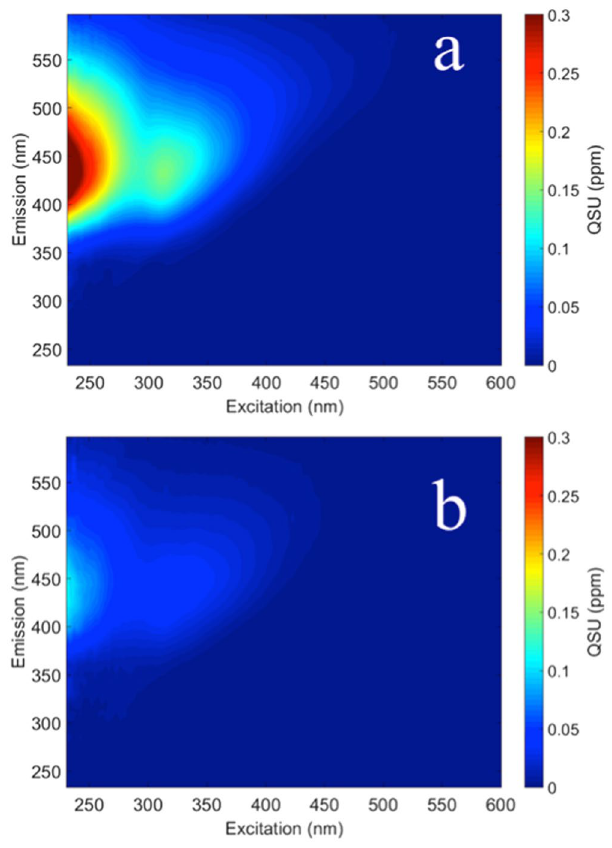
Figure 4. Increase in fluorescence over a 5 week dark and anaerobic incubation of freshwater sediments with sulfate/acetate treatment ( a ) and acetate only treatment (fermentation) ( b